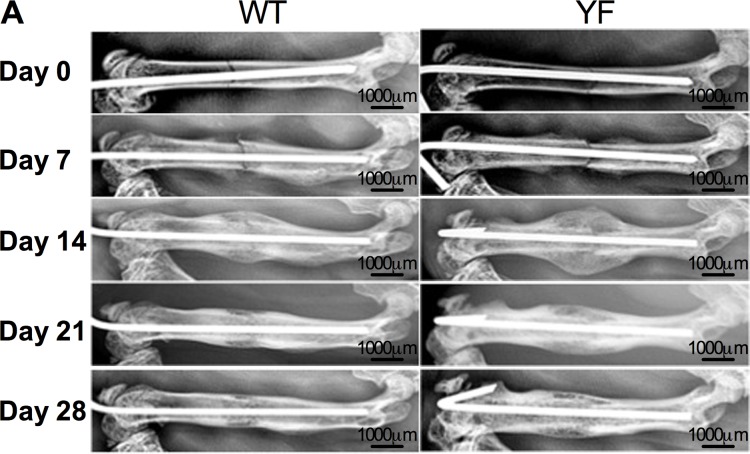
Radiographic images show increased callus formation and delayed callus resorption in mice lacking Cbl-PI3K interaction.Representative WT and YF mice were X-rayed once a week for four weeks to observe pin fixation, confirm fracture, and monitor callus formation.